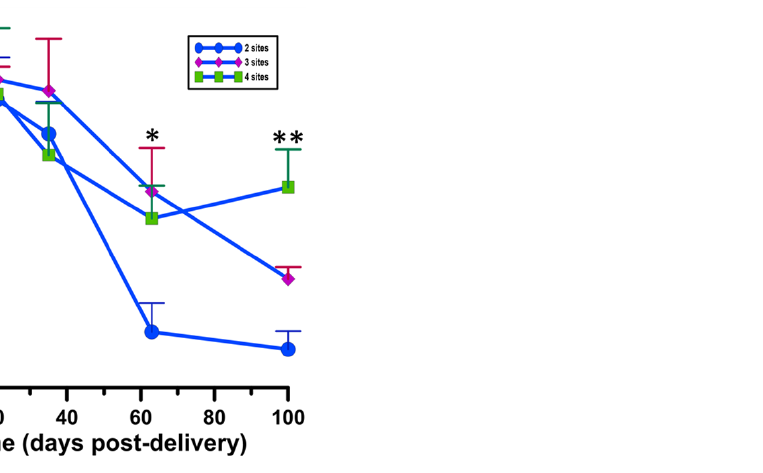
Figure 9. Scalability of Factor IX delivery via moderate heat-assisted GET. Human Factor IX in guinea pig serum. The data represent the average ± SEM, n = 5 individuals per group. * p < 0.05, ** p < 0.01.